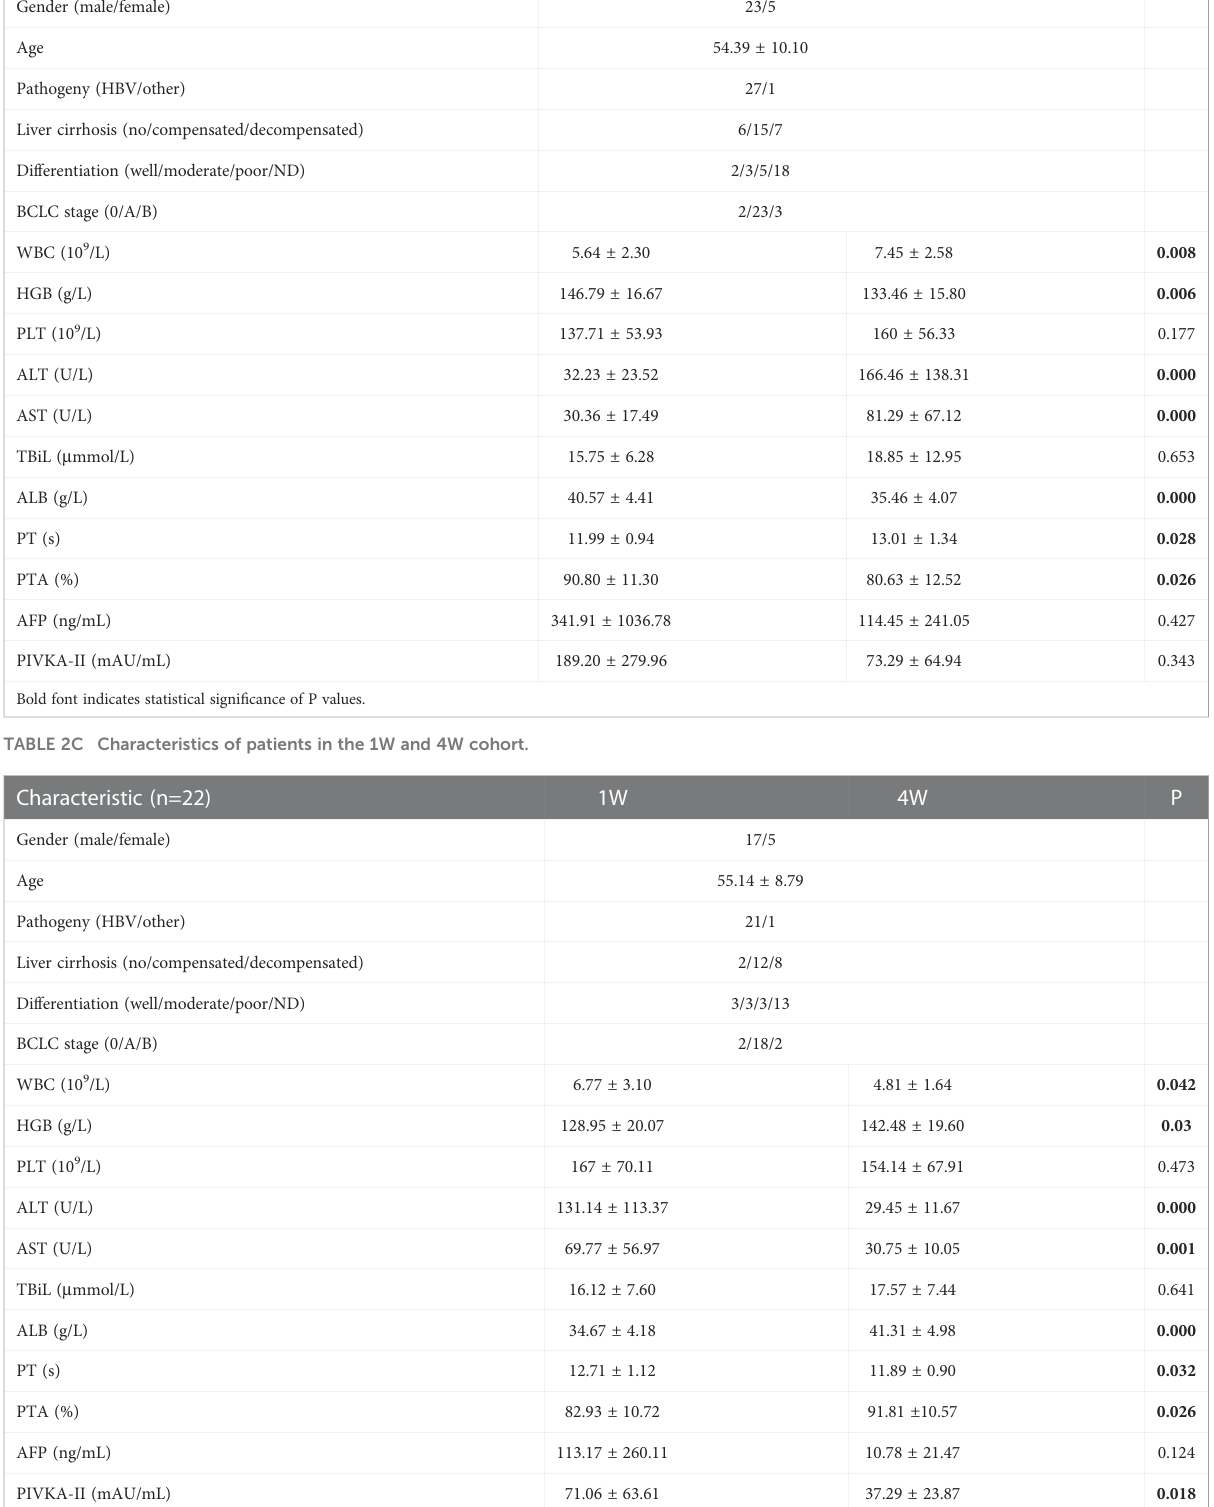
Bold font indicates statistical signi fi cance of P